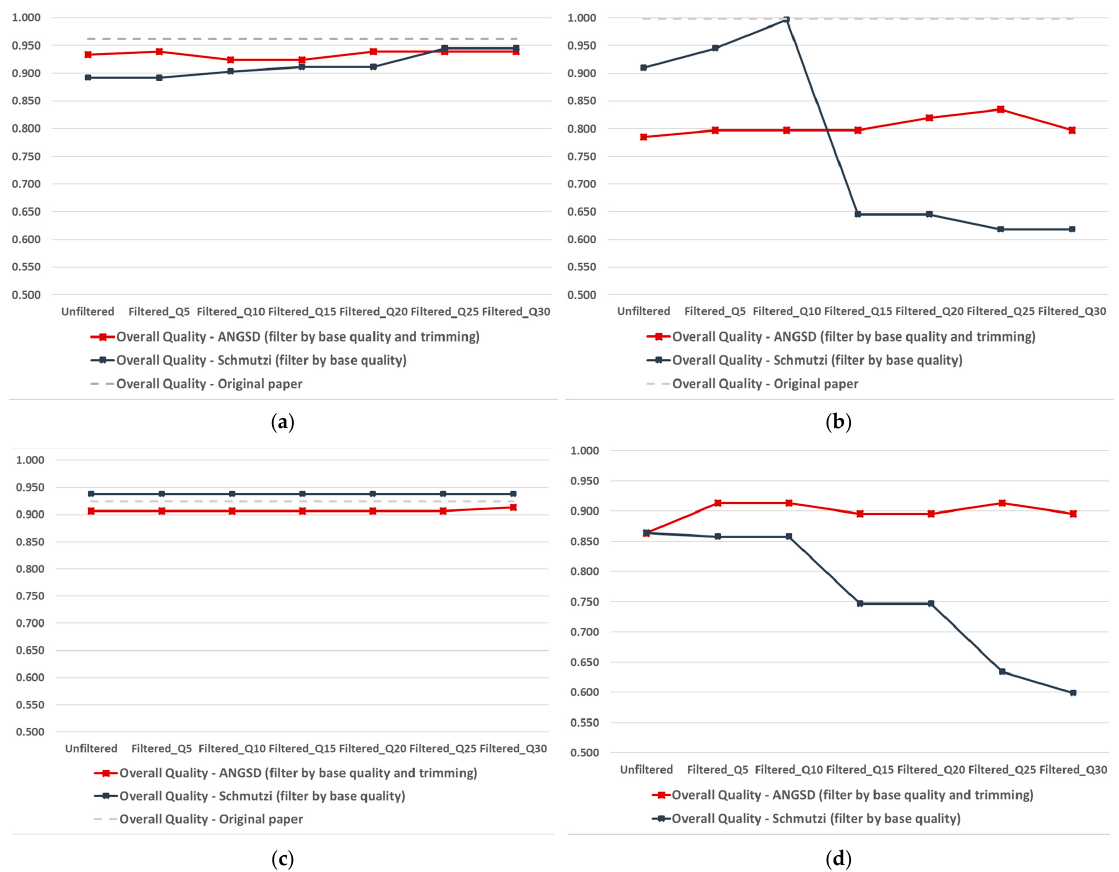
Figure 1. Haplogroup prediction accuracy using mitogenome consensus sequence extracted from raw genomic data, as derived by two alternative tools and pipelines (ANGSD vs. schmutzi). Selected samples shown (display of all samples in Figure S1): ( a ) ZBC [29] is a moderate-coverage sample, in which quality filtering slightly improved overall quality; ( b ) ZMOJ [29] is a low coverage sample, in which quality filtering had a differential effect on overall quality, as applied by the two alternative tools; ( c ) ZHJ [29] is a low-coverage sample, in which quality filtering did not have any effect on the overall quality; ( d ) KRD003 [30] is a very low-coverage sample, in which quality filtering had a differential effect as applied by the two alternative tools, with a progressive reduction in the overall quality for one